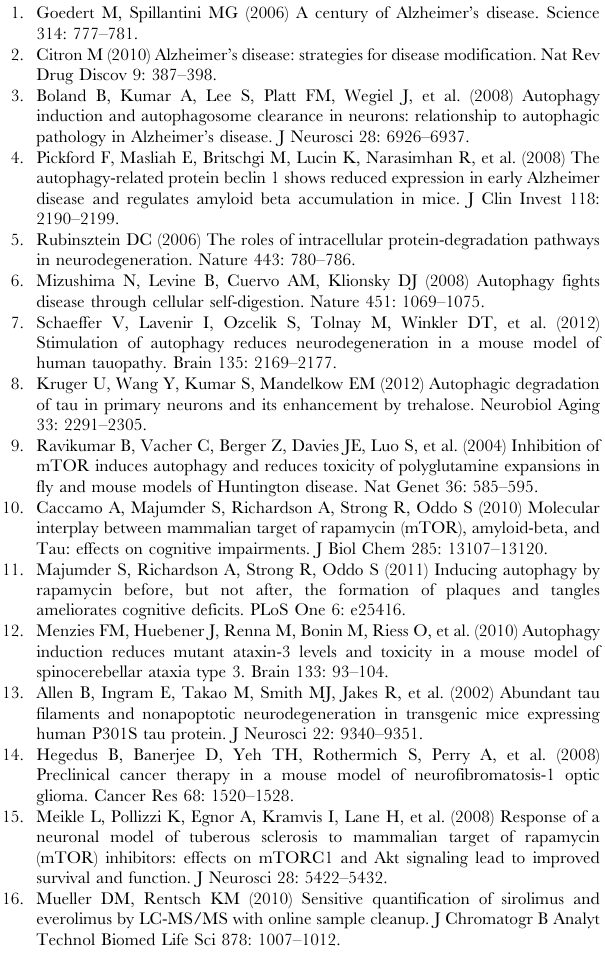
Figure S4 Intraperitoneal rapamycin administration resulted in high cerebral rapamycin levels as measured by HPLC. Similar levels were achieved in the forebrain and the brain stem (A; B6